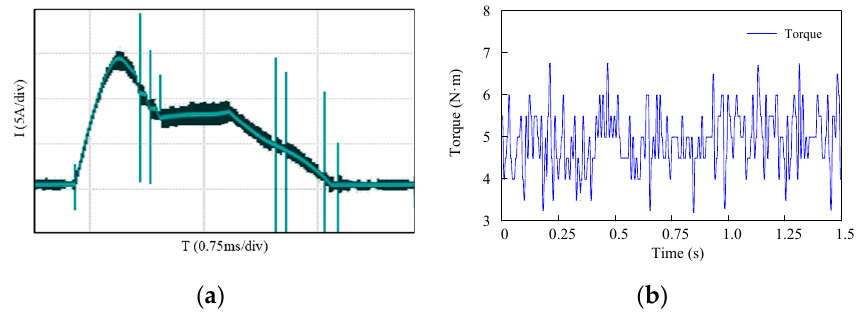
Figure 17. Waveforms of conventional TSF at 1000 r/min: ( a ) current; ( b ) torque.